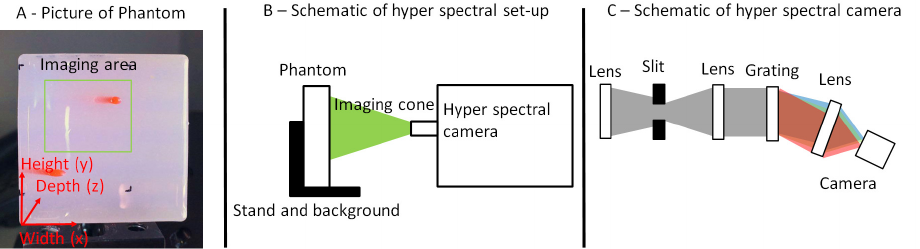
Figure 1. ( A ): Sample phantom with inclusions filled with a red ink water solution. The green rectangle shows the part of the phantom for which the data analysis is done. Only the upper inclusion was used for the analysis as the lower one would be prone to boundary effects. The inclusion has a diameter of two millimeters and it is drilled from the top to the bottom surface. On the right part, it crosses the top surface (closer to camera) while in the left part, it crosses the bottom surface (further away from the camera). ( B ): Set-up. The phantom is illuminated from the side and imaged with the hyper-spectral camera (adapted from [18]). ( C ): Schematic of the set-up of the hyper-spectral